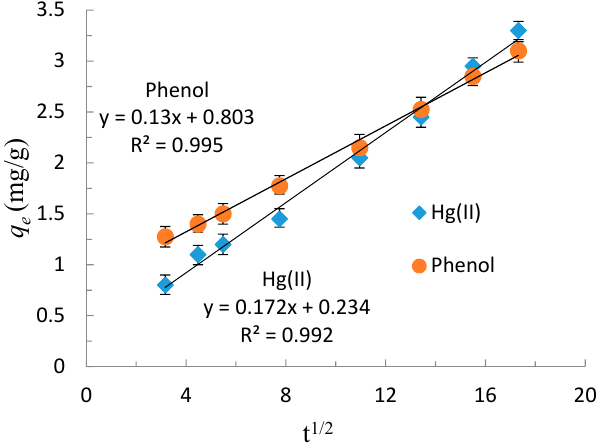
Figure 6. Plots of the intra-particle diffusion model for Hg(II) and phenol removal using functionalized-AC (Initial (Hg(II)/phenol) concentrations: ~10 mg/L, pH: 5.0, solid dose: 2.0 g/L, contact time: 12 h).